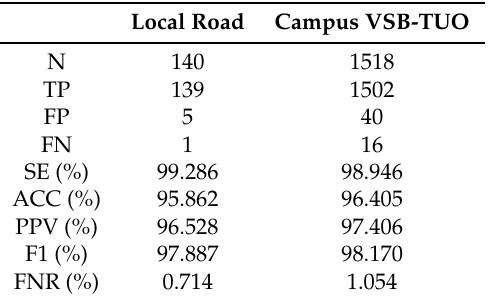
Table 3. Classification analysis of detected car